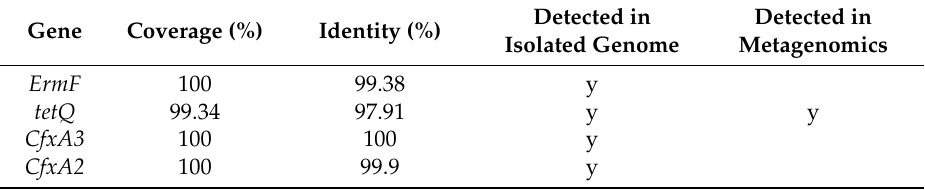
Table 2. Predicted resistant genes in Prvotella sp.